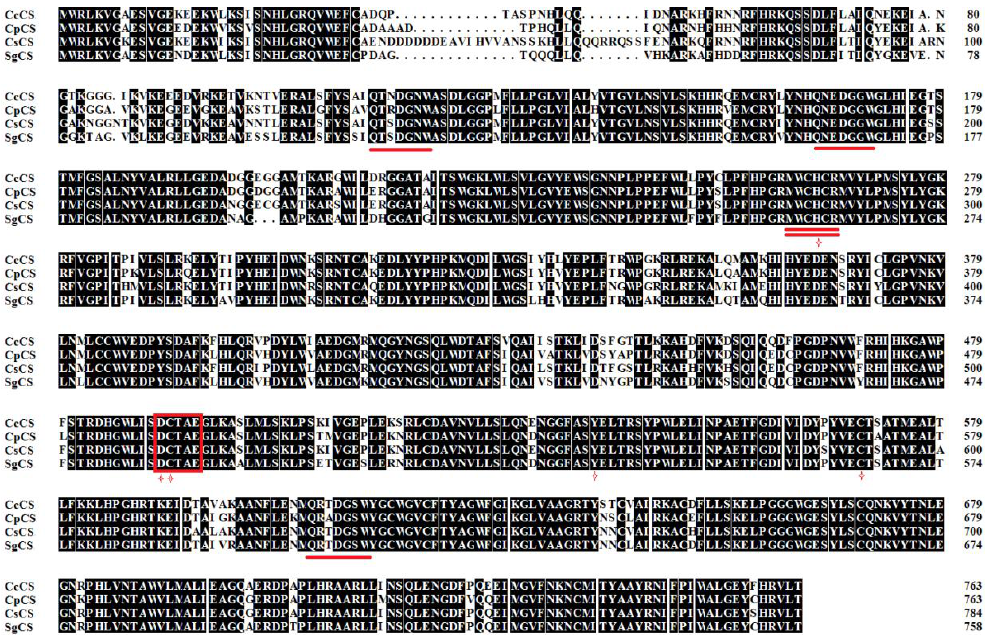
Figure 2. Multiple sequence alignment of the putative SgCS protein and three other cucurbitadienol synthases, GenBank accession numbers: CcCS (KM821405), CpCS (AB116238), CsCS (AIT72030), SgCS (HQ128567). The highly conserved DCTAE motif marks in red. A terpene synthase feature of QXXXXXW motif is single underlined. MWCHCR motif is shown in the double underline. Important catalytic residues are marked with stars (Asp486, Cys487, Cys565, Tyr535, and His260) which are necessary for 2,3-oxidosqualene cyclization into cucurbitadienol.